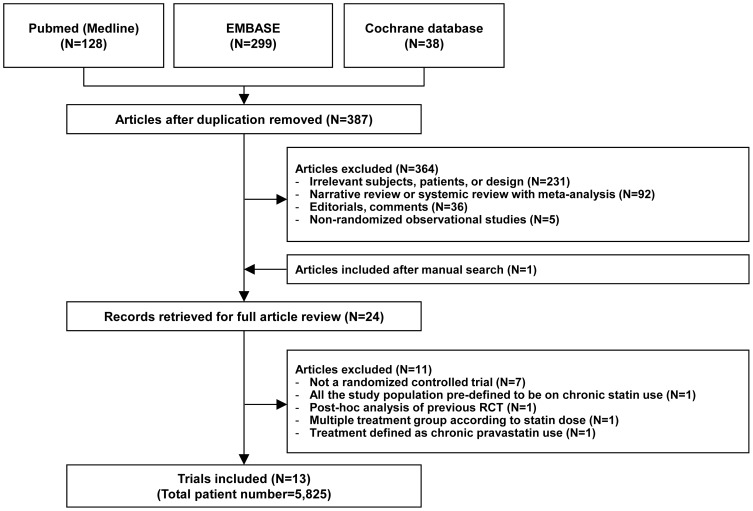
Flow diagram of trial selection.Abbreviations: RCT, randomized controlled trial.